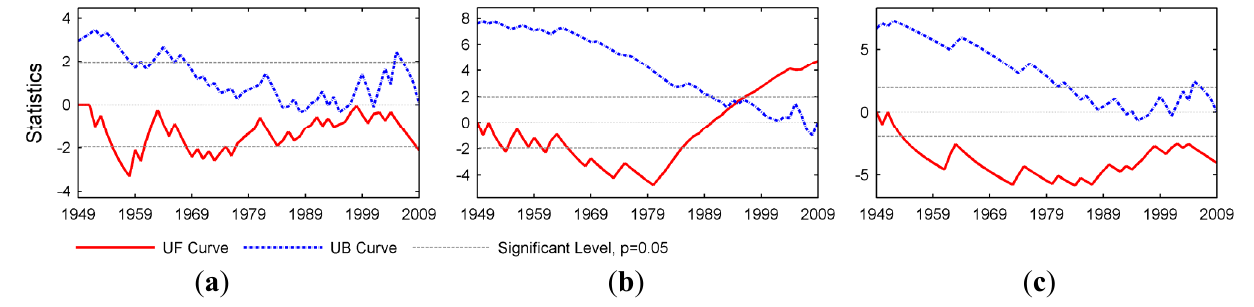
Figure 7. MK test for agricultural waterlogging ( a ); urban waterlogging ( b ); and mixed waterlogging ( c